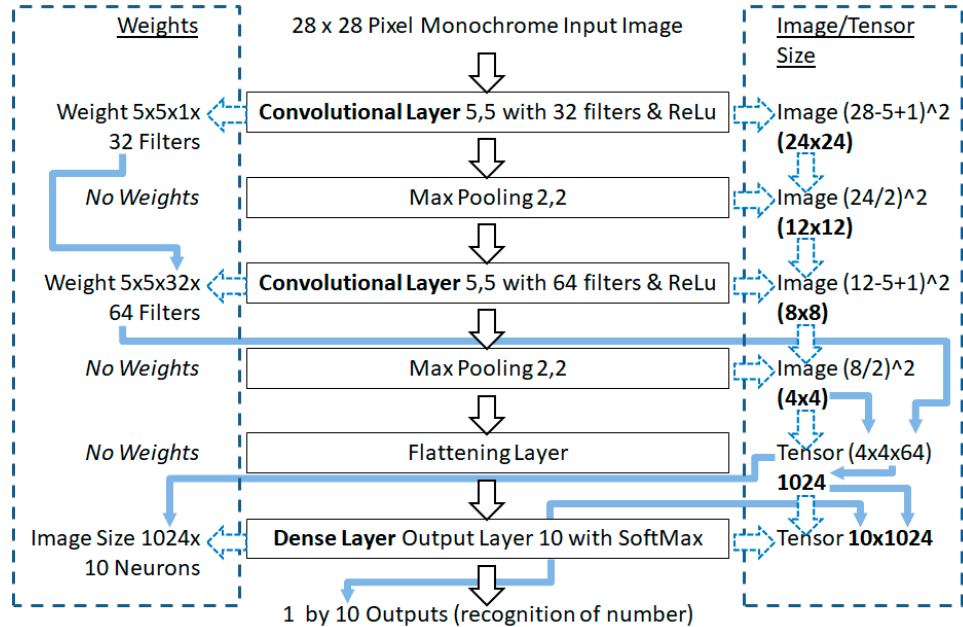
Figure 3. Weight and image size adjustments of layer parameters in the Torres benchmark model.